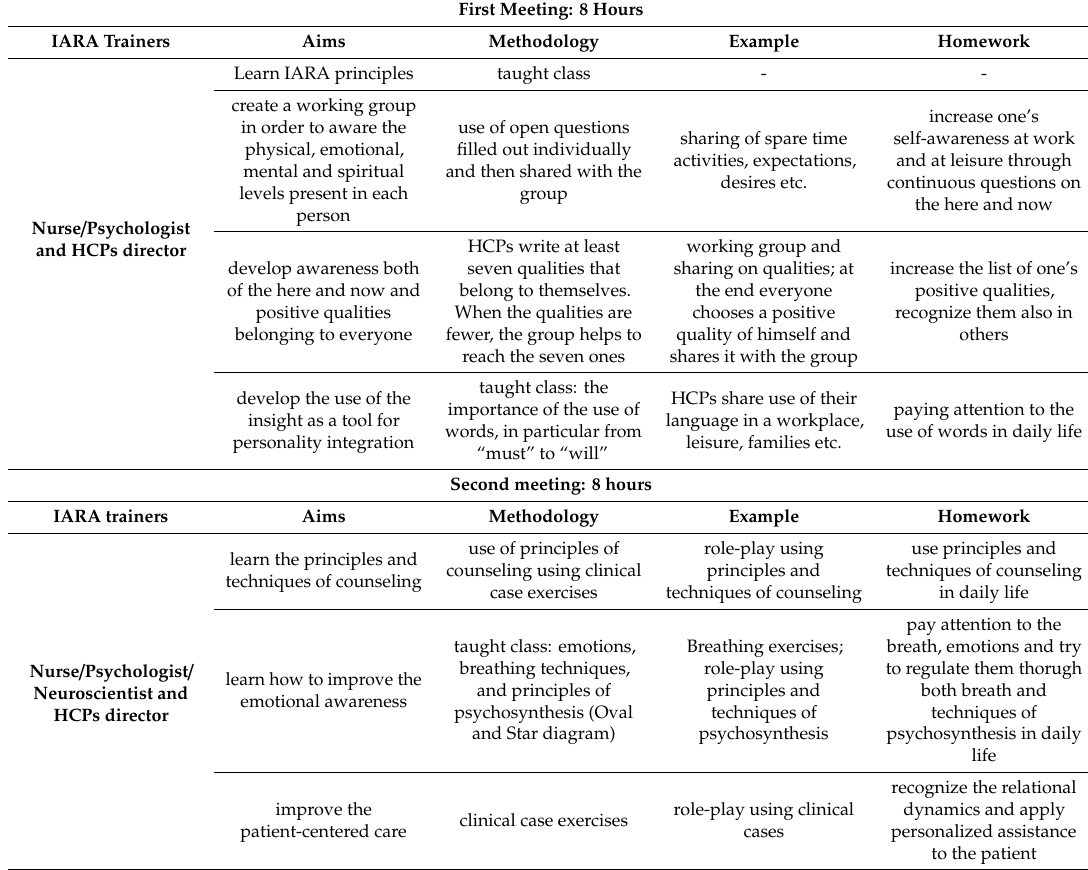
Table 1. Step by step diagram of the IARA training sessions (HCPs, healthcare professionals; IARA, IARA Model ® ; SWOT, Strengths, Weaknesses, Opportunities and Threats